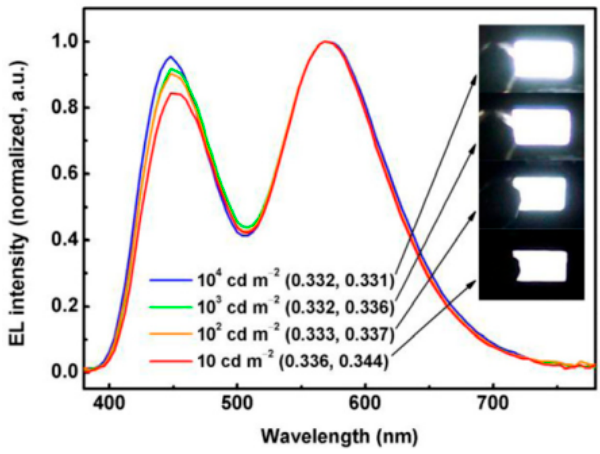
Figure 4. Spectra of the WOLED at various luminances. Reproduced from Reference